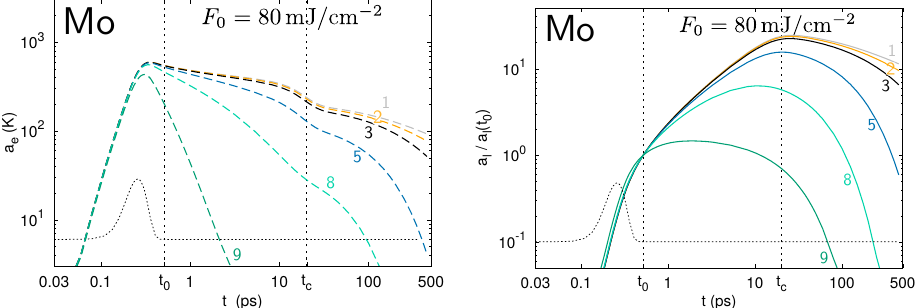
Figure 5. The same as in Figure 4 for aluminum.